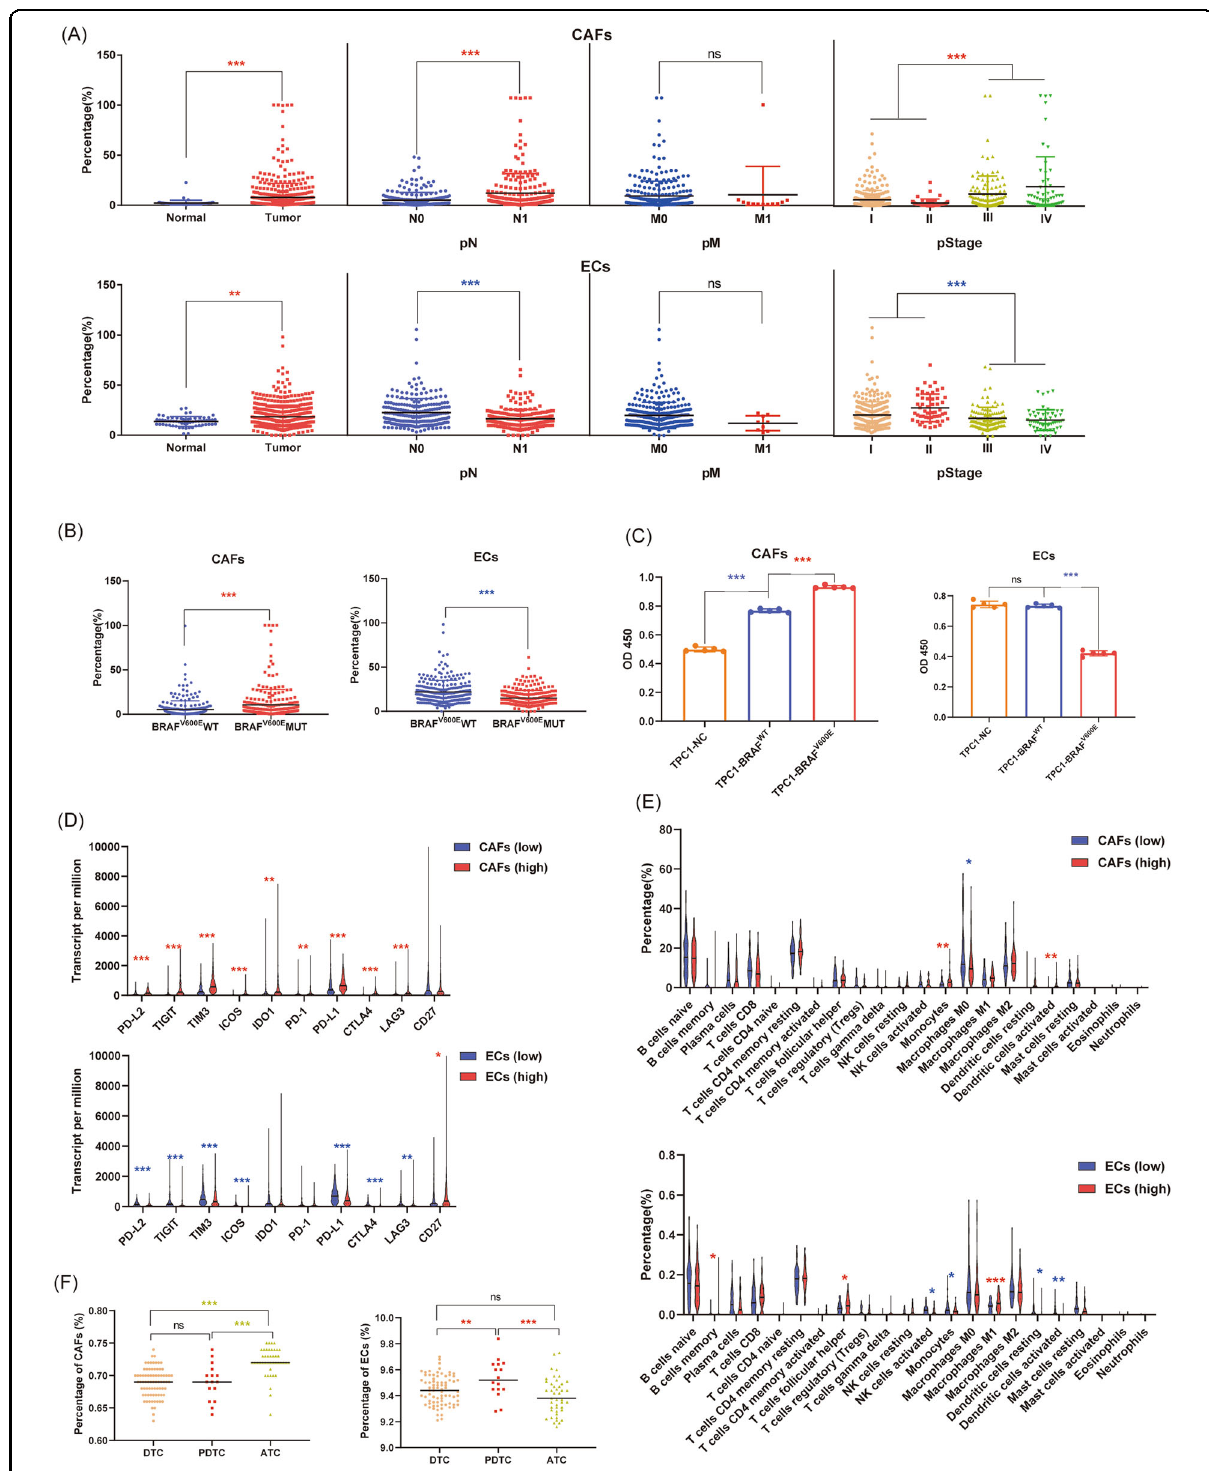
Fig. 6 Cancer-associated fi broblasts and endothelial cells in thyroid cancer. A Expression of cancer-associated fi broblasts (CAFs) and endothelial cells (ECs) in different pathological stages of PTC and healthy thyroid tissues. B Association of the BRAF V600E mutation with CAFs and ECs in PTC. C The proliferation of CAFs and HUVECs (ECs). Co-cultured with TPC1 transfected with wild-type (WT) BRAF and BRAF V600E mutation. D Association of immune checkpoints with CAFs and ECs in PTC. E Association of immune cells with CAFs and ECs in PTC. F Expression of CAFs and ECs in different pathological types of thyroid cancer. (ns no signi fi cance, * P < 0.05, ** P < 0.01, *** P < 0.001).